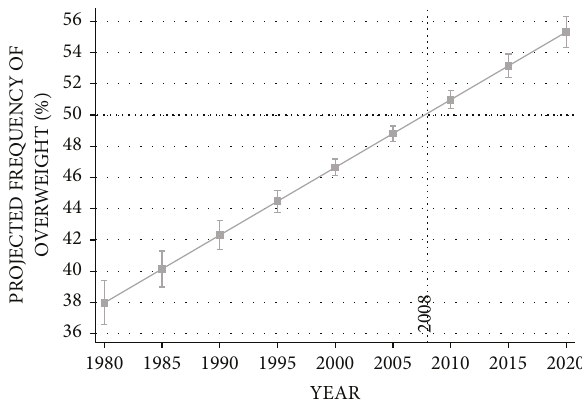
Figure 2: Changes in overweight and obesity prevalence in 23 OCED countries, 1980–2020. The vertical axis measures the pro- jected relative frequency of overweight and obesity (BMI ≥ 25 where BMI � kg/meter 2 ) in the population of 23 OECD countries based on measured height and weight. The horizontal axis mea- sures the year in which the measurement took place. The figure is based on the following fixed-effect regression outcomes given in column (2).